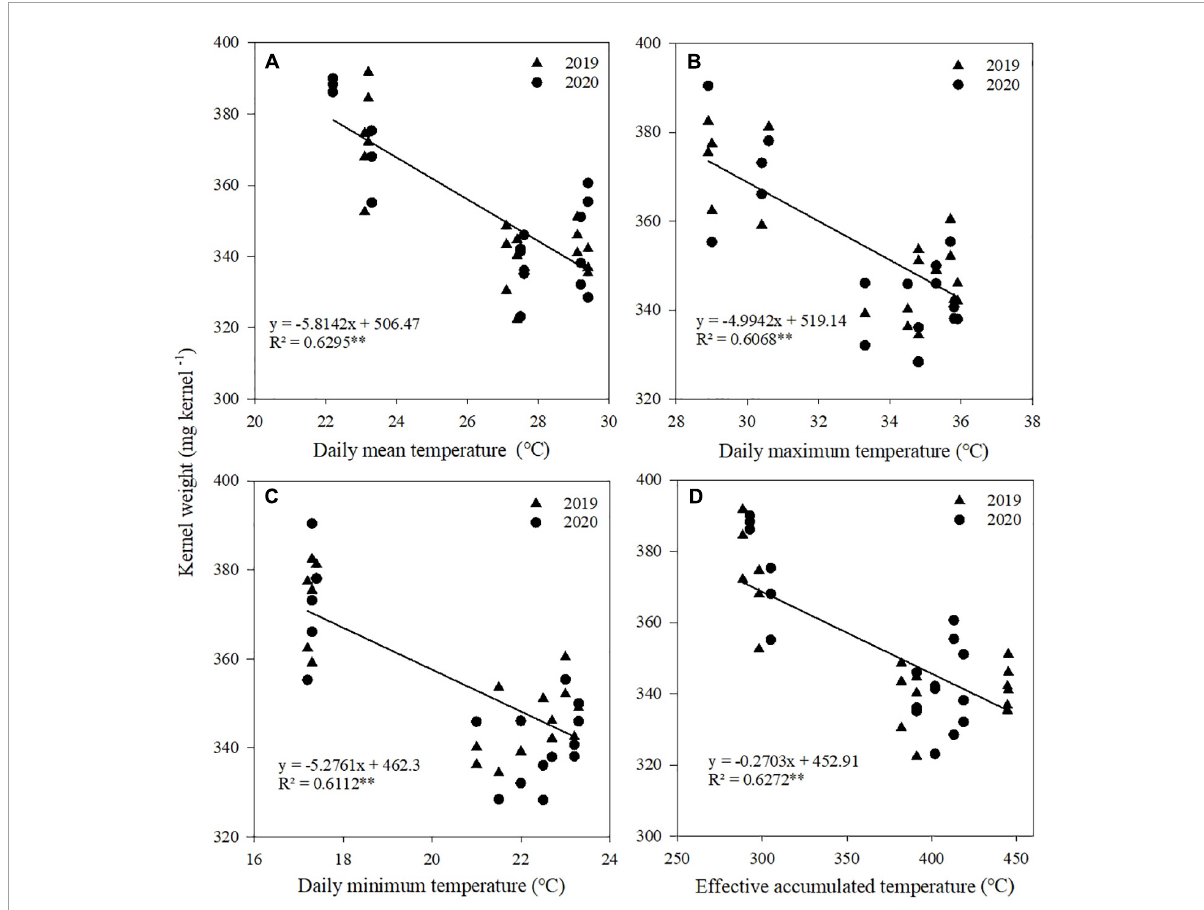
FIGURE6 Relationships between kernel weight and daily mean temperature (A) , daily maximum temperature (B) , daily minimum temperature (C) , and effective accumulated temperature (D) from R1 to R3. **Significant at the 0.01 probability